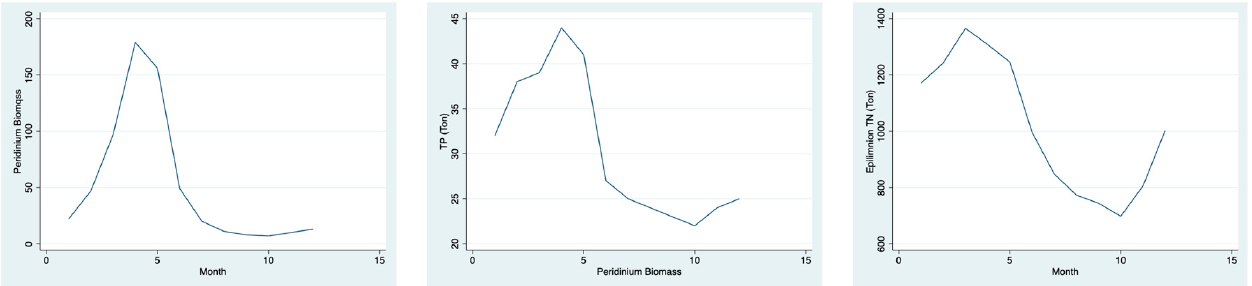
Figure 15. Scatterplot chart of monthly (1–12) fluctuation averaged for 1970–2018: Peridinium wet biomass (g/m 2 ) ( left ), total phosphorus (TP) ( middle ) and total nitrogen (TN) ( right ) during 1970–2018.